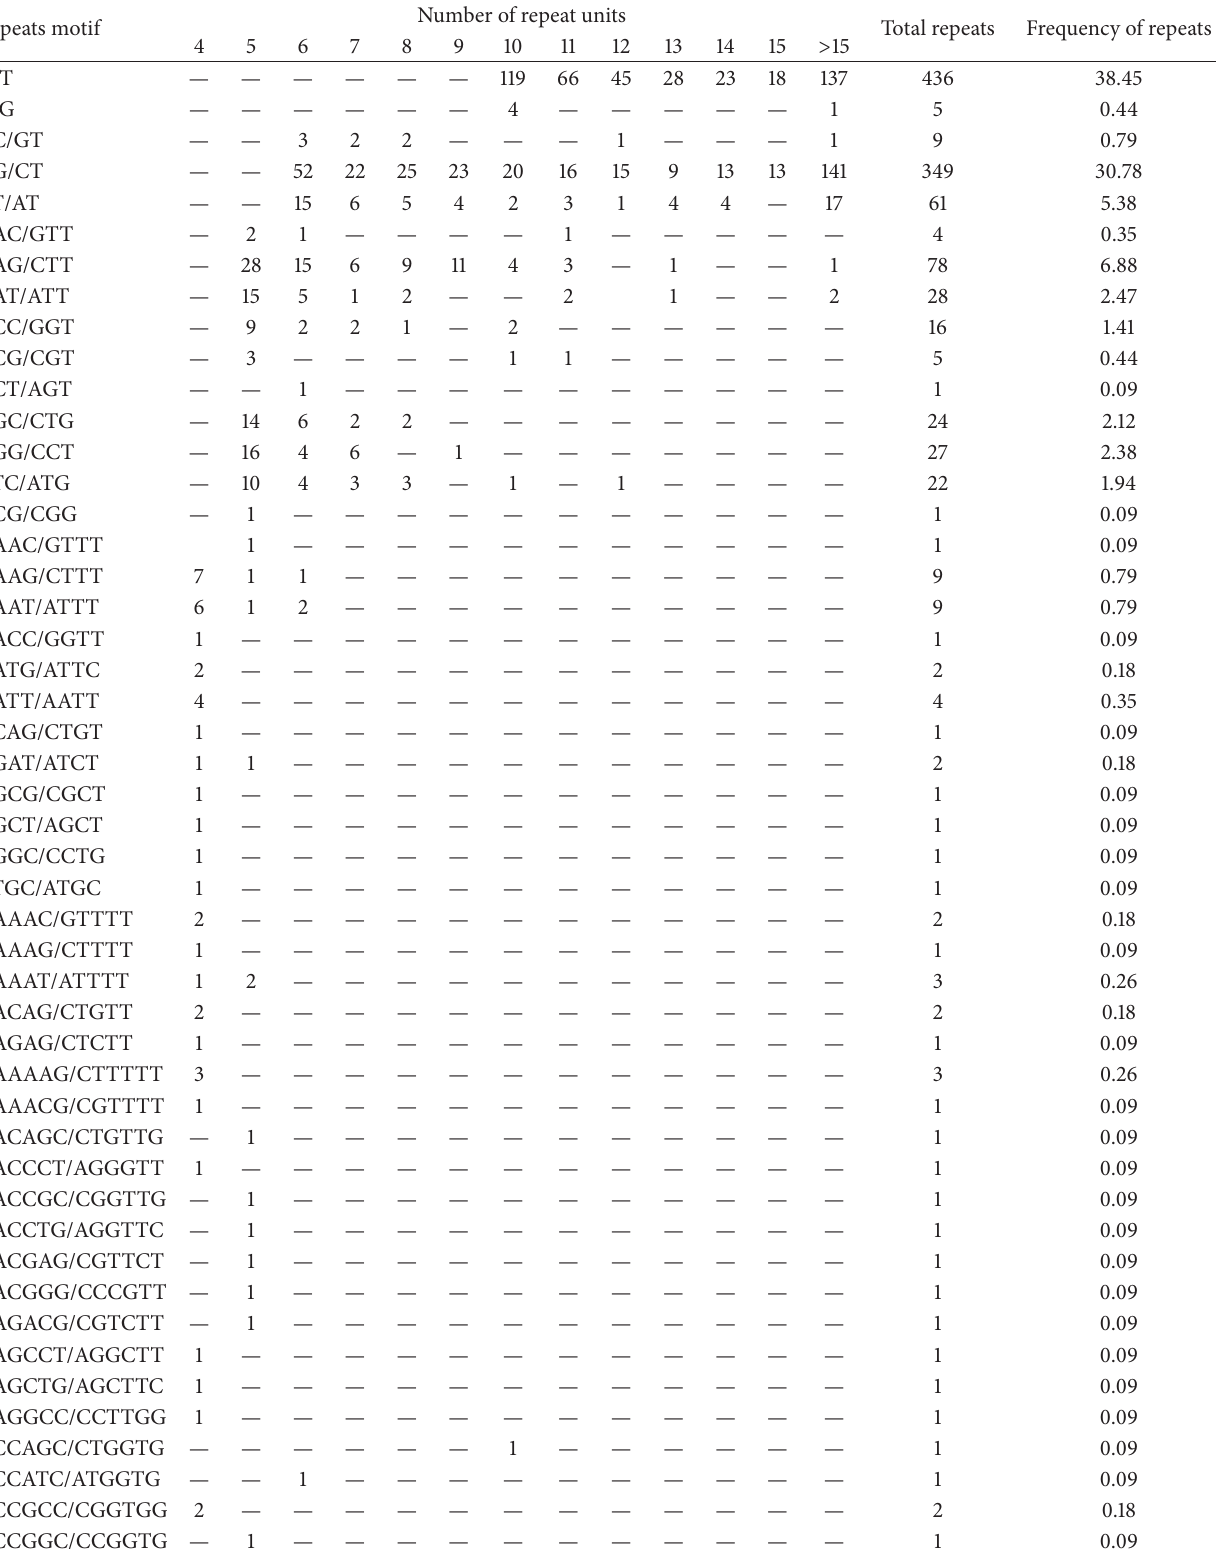
Table 3: Frequency of classified repeat types (considering sequence complementary) in the analysed 840 splicing sequences. Repeats